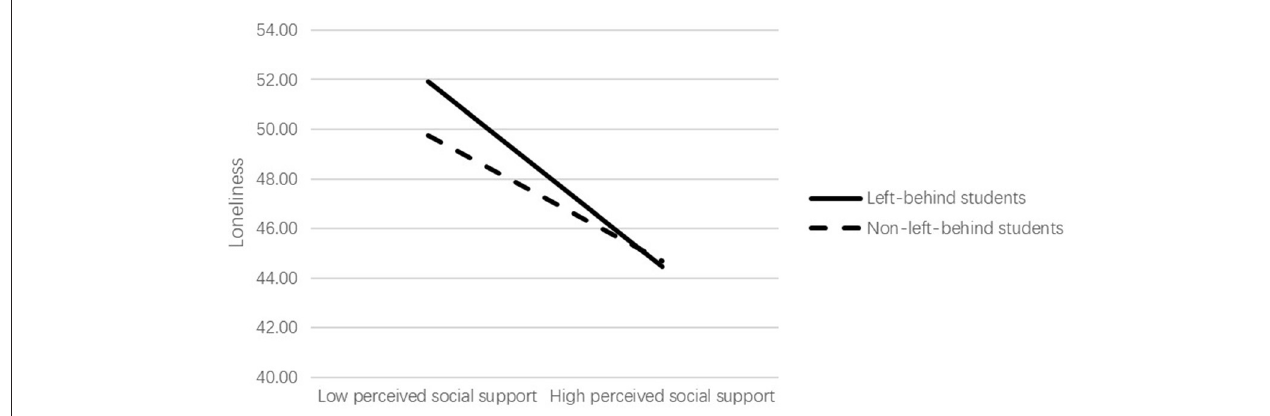
FIGURE 2 | Left-behind status as a moderator of the association between perceived social support and loneliness.